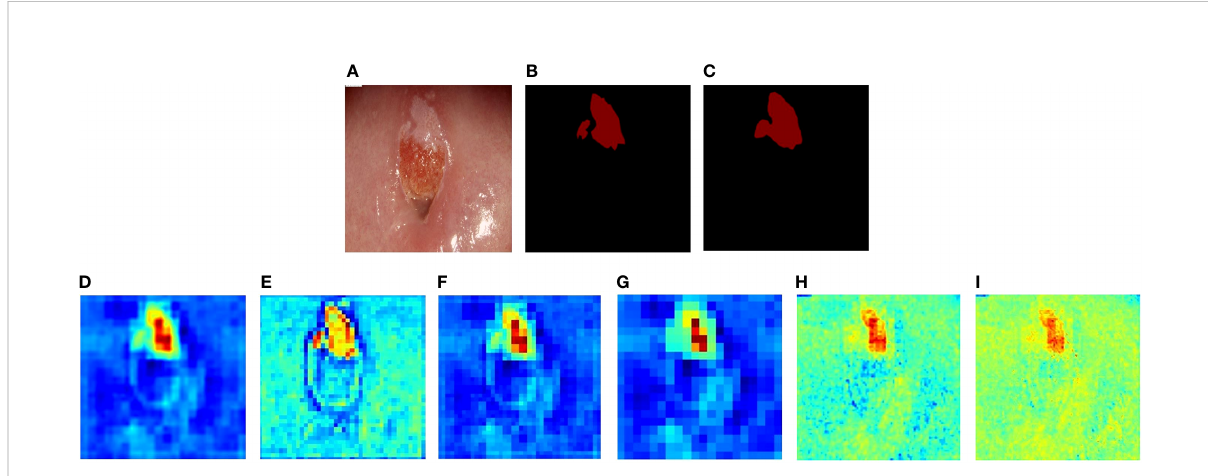
FIGURE 6 The heatmaps of CLS-Net ’ s features. (A) Colposcopic post-acetic-acid images. (B) The ground truth. (C) The result of CLS-Net. (D) The heatmap of feature2 unsampled by 2. (E) The heatmap of feature1 after going through the convolution layer and BN layer. (F) The result of feature1 adds up to feature2. (G) The heatmap after upsampling to the size of the original image. (H) The heatmap of the 8th layer output. (I) The result of (F) adds up to (H) .